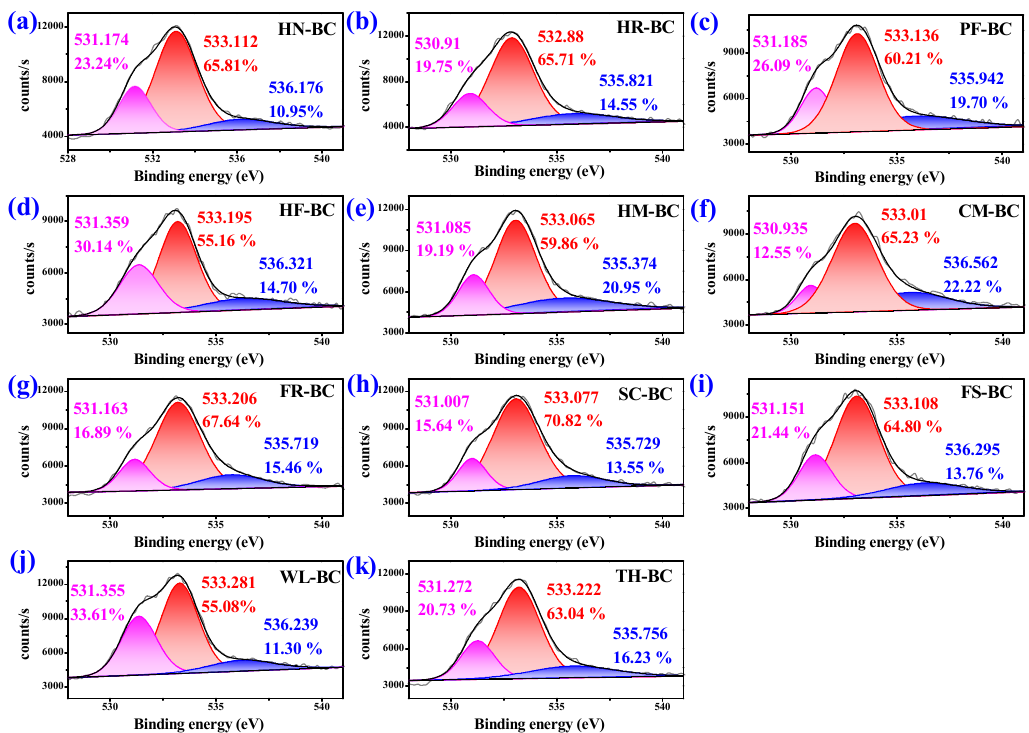
Figure 3. XPS (O 1s) spectra of AKWs-BC and TH-BC: HN-BC ( a ); HR-BC ( b ); PF-BC ( c ); HF-BC ( d ); HM-BC ( e ); CM-BC ( f ); FR-BC ( g ); SC-BC ( h ); FS-BC ( i ); WL-BC ( j ); TH-BC ( k ).